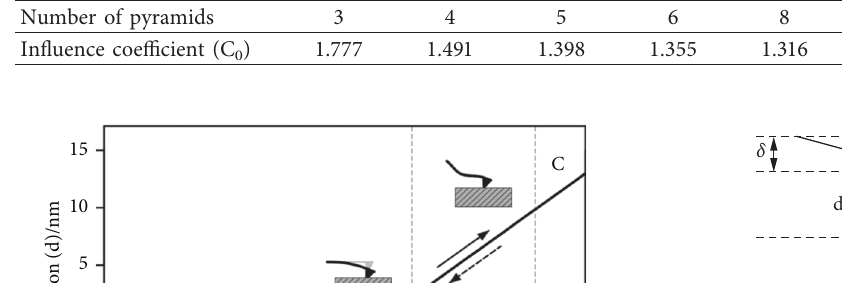
Table 1: Force–indentation coefficients.